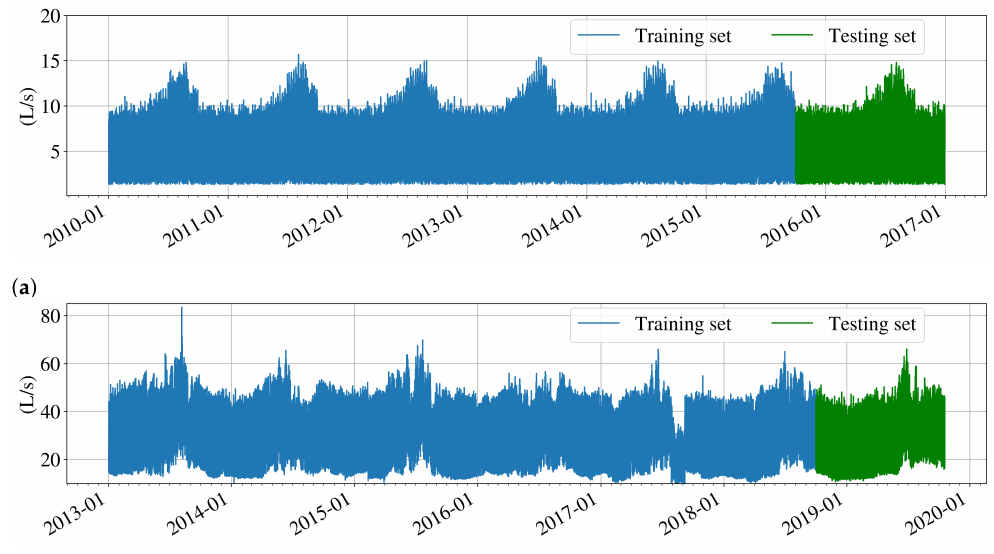
Figure 1. Full length of the time series of water consumption adopted in this study. ( a ) depicts the synthetic time series ( ts 1), whereas ( b ) represents a real consumption of a WDS in Trentino ( ts 2).